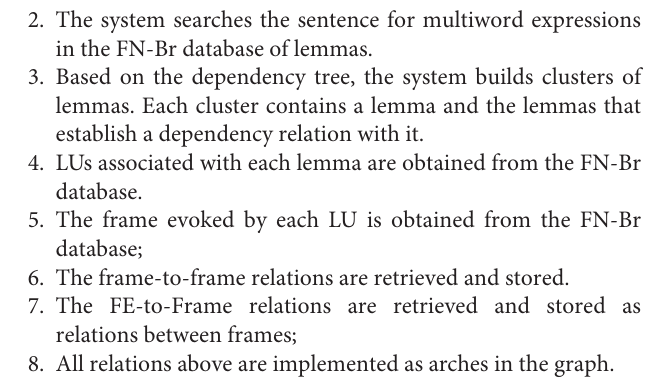
the most known examples of frame-based semantic role